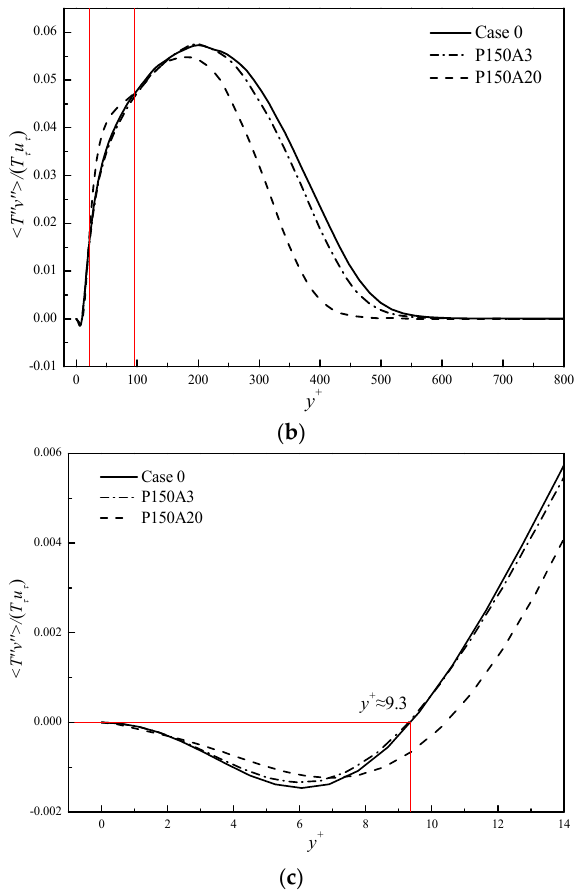
Figure 14. Profiles of Reynolds shear stress ( a ) and normal turbulent heat flux ( b ) at x = 40.775. The near ‐ wall region in ( b ) is zoomed in ( c ).